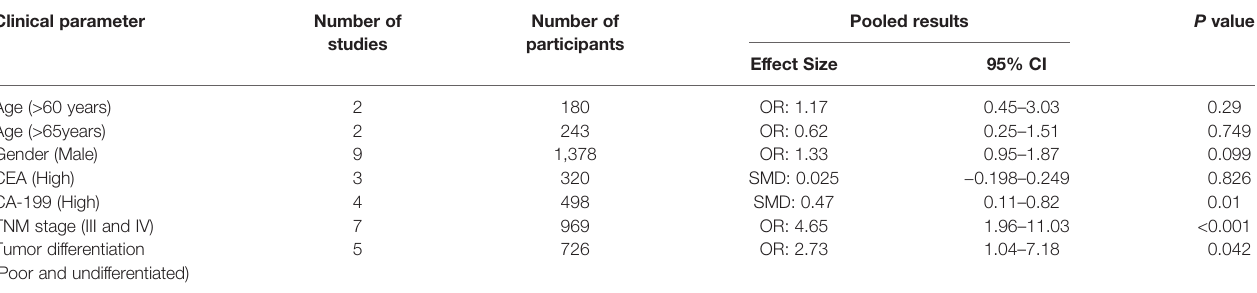
TABLE 2 | The association between elevated neutrophil-to-lymphocyte ratio (NLR) and clinical features. Clinical